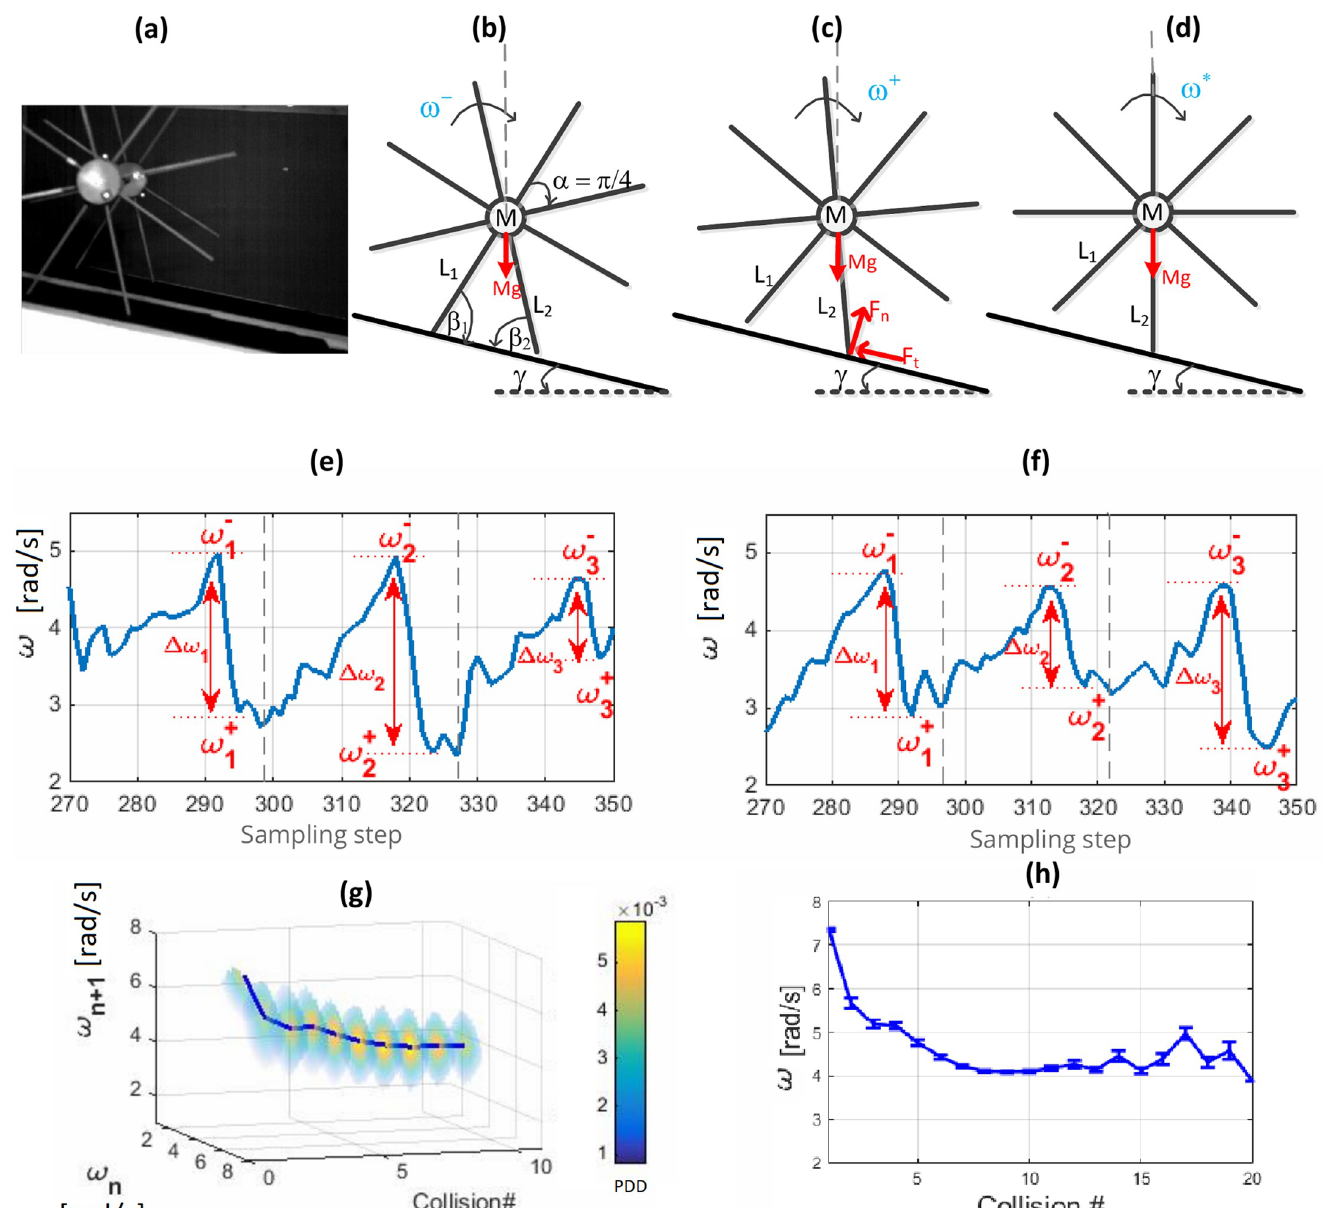
Fig 1. The motion of an 8 spoke RW as a meta-stable walker. (a) A snapshot of an example RW in passive motion on a slope. (b)-(d) Schematics of the side-view of the RW just before collision, just after collision and at the vertical position of leg L2. (e), (f) Continuous plots of the angular velocity during a few steps of two trials of an experimental setup of a RW. The angular velocities just before and just after collision are presented as ω − and ω + respectively and the angular velocity drop during collision is shown as Δ ω . The variability of Δ ω during each collision contributes to the state variability during the steady state. The vertical dashed lines represent the minimum angular velocity position per cycle corresponding to the mid-stance RW position shown in Fig 1(d). (g) Probability distribution of angular velocity just before collision ( ω ) in its return map space for 10 collisions for the 50 experiment trials. The color-bar shows the probability density distribution at each step showing a 3D Gaussian probability density distribution around the steady state at each step of the walk. (h) The mean and standard deviation of ω for experimental and simulated datasets of the RW.